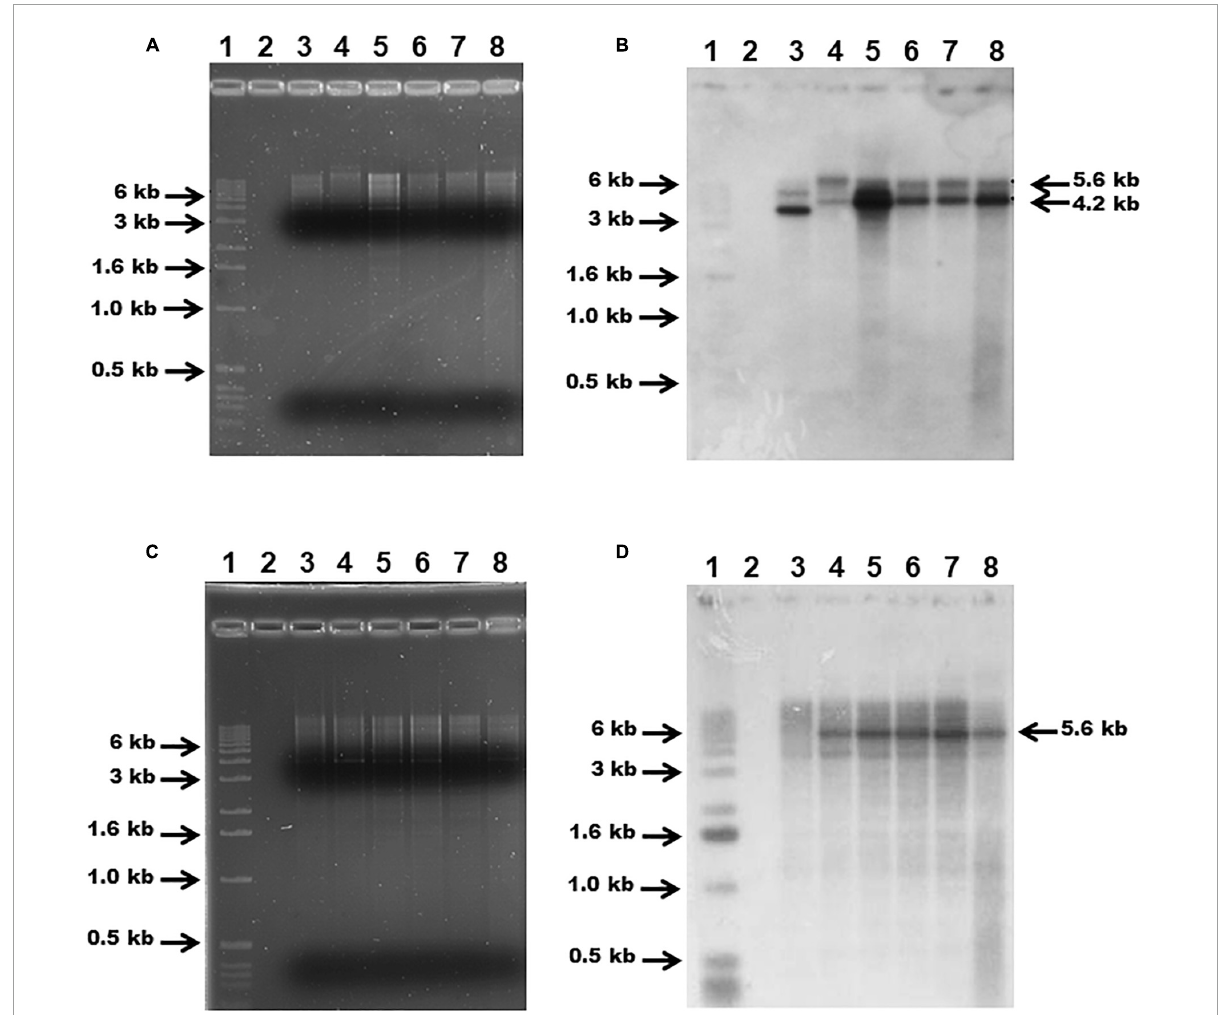
FIGURE5 Agarose gel (1%) electrophoresis of G. anatis total DNA digested with Hind III (A,C) and DNA-DNA hybridization (B,D) : using flavodoxin-fur [2.2 kbp, (B) ] or streptomycin [1.5 kbp, (D) ] gene probes, respectively. (1) 1 kbp MWM, (2) empty, (3) G. anatis 12656-12 (wt). The mutants are in the following lines: (4) (cid:127) fur 126.13, (5) (cid:127) fur 126.5, (6) (cid:127) fur A1, (7) (cid:127) fur A2, (8) (cid:127) f ur